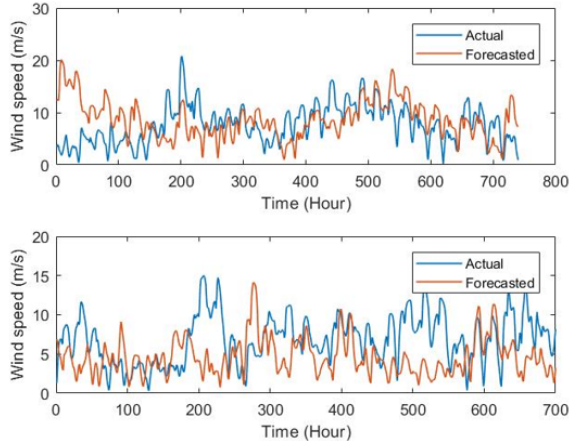
Figure 17. Forecasted and actual wind speeds of 2017, June & July, Dhahran, Case